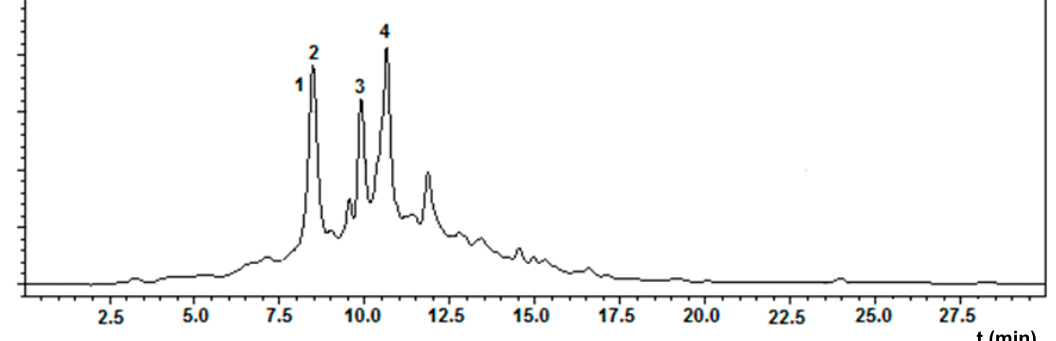
Figure 1. HPLC analysis of F.EtOAc.2 fraction of P. friedrichsthalianum fruit (C 18 -column, λ = 370 nm). Compounds: 1 : procyanidin B1; 2 : procyanidin B2; 3 : unidentified; and 4 : ellagic acid.